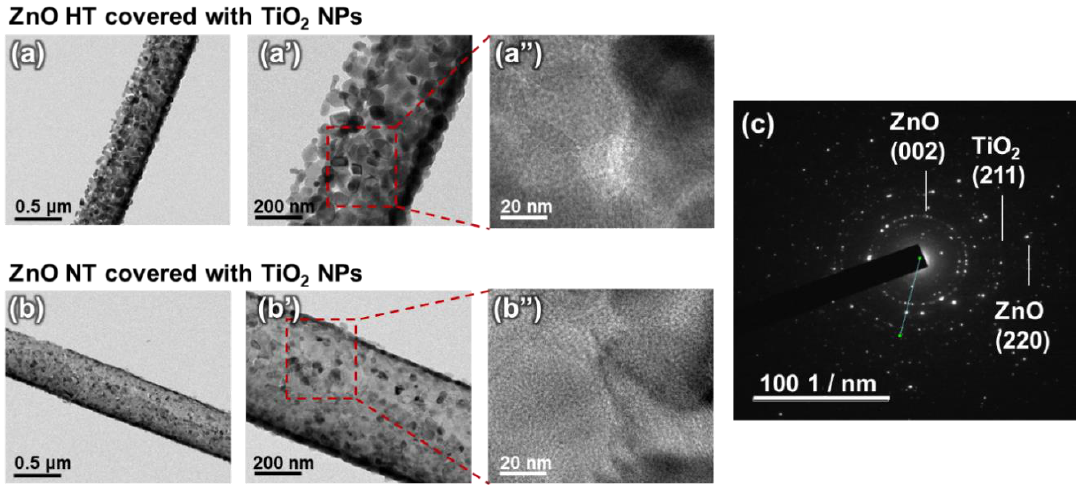
Figure 3. ( a ), ( a’ ), ( b ), and ( b’ ) Low-magnification bright field (BF) TEM images of ZnO HTs and NTs covered with TiO 2 NPs. ( a’’ ) and ( b’’ ) High-resolution TEM images of dotted red rectangular region in the magnified BF TEM images of ( a’ ) and ( b’ ). ( c ) Selected area electron diffraction (SAED) pattern of the ZnO NT covered with TiO 2 NPs.